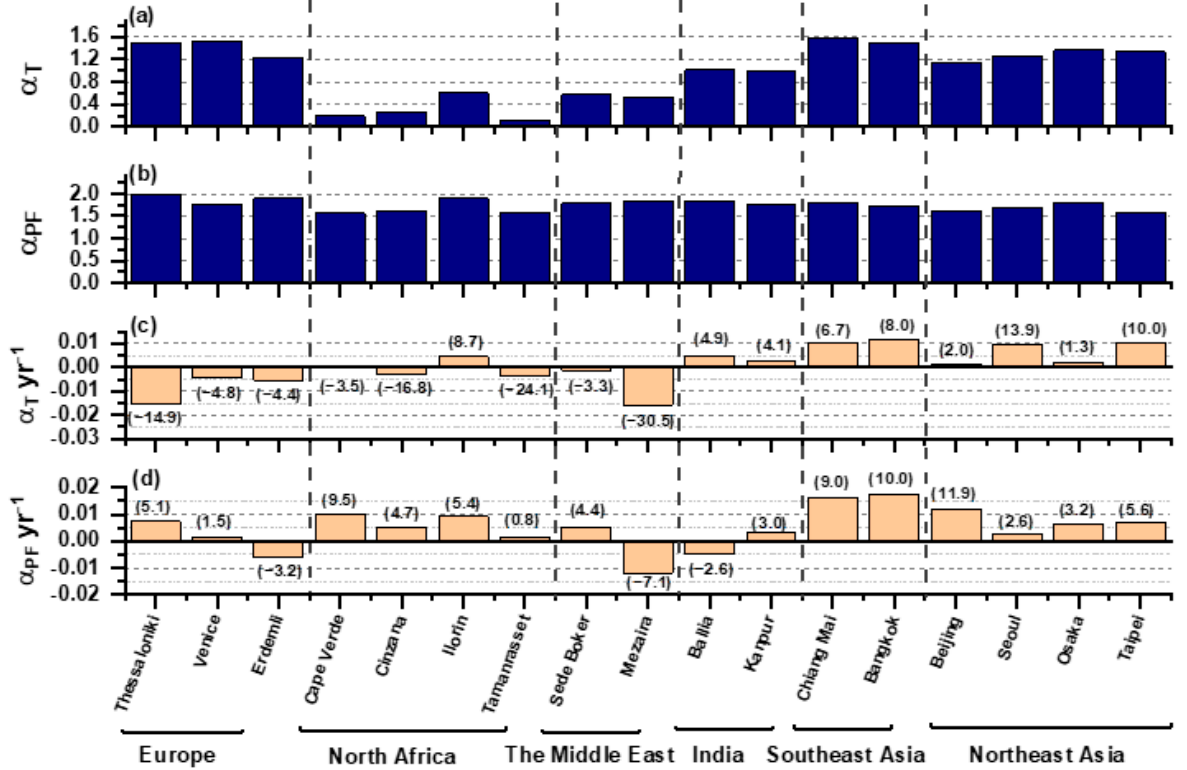
Figure 4. Average Ångström exponent ( α ) of ( a ) total and ( b ) fine-mode pollution particles, and the change of the annual values of the ( c ) total Ångström exponent ( α T ) and ( d ) fine-mode pollution Ångström exponent ( α PF ). The values inside the brackets present the percent variation for each of the 17 sites.